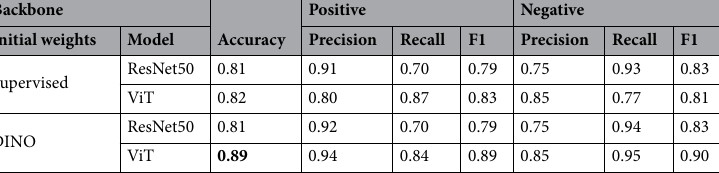
Table 5. DL classification results: frames are aggregated over each video using majority voting. Best value is in bold.